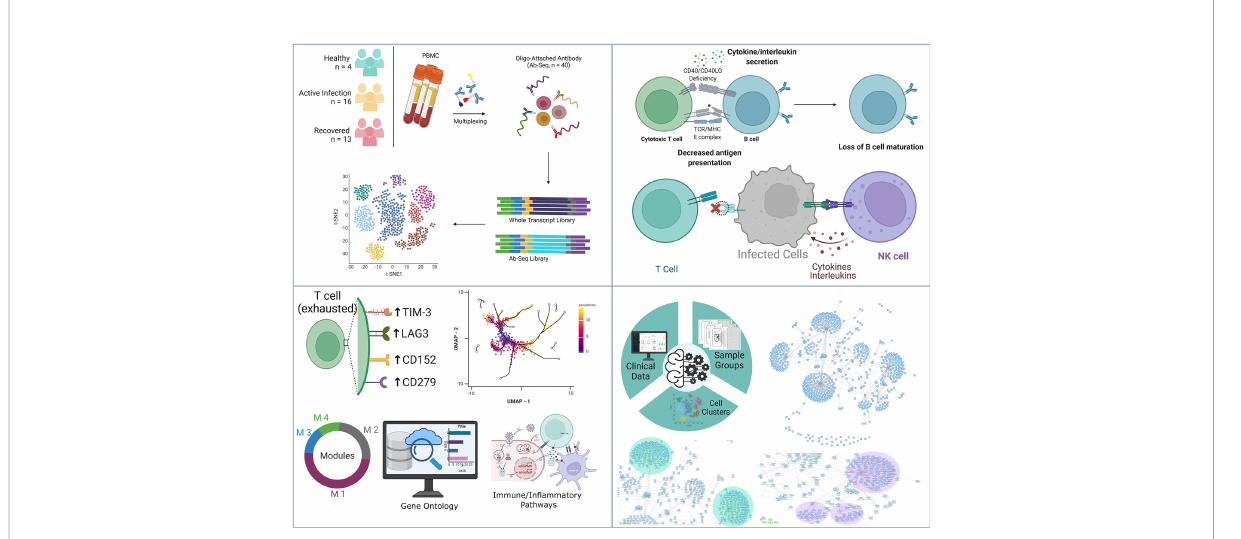
FIGURE 6 Summary of the key fi ndings from the study. It highlights the observed T-cell dynamics within the COVID-19 patients, recovered individuals and healthy, as well as key immune fi ndings harnessing strength of machine